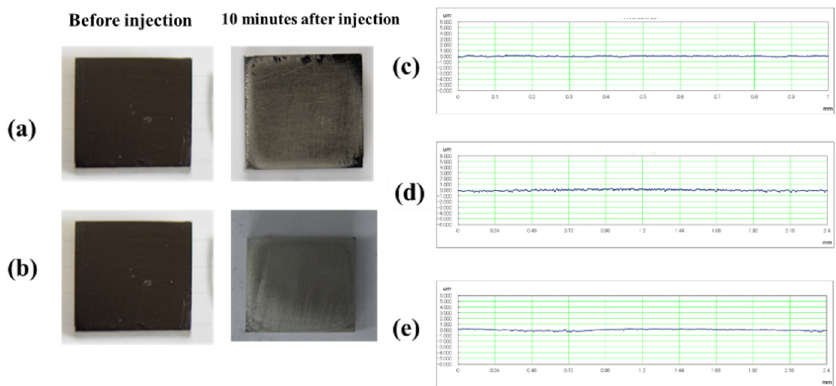
Figure 8. Images of the titanium surface before and after 10 s blasting of: ( a ) agar, and ( b ) glycine particles, are shown. The cross-sectional curves before blasting and after 10 s blasting of each particle are shown: ( c ) before blasting, ( d ) after blasting of agar, ( e ) after blasting of glycine particle.